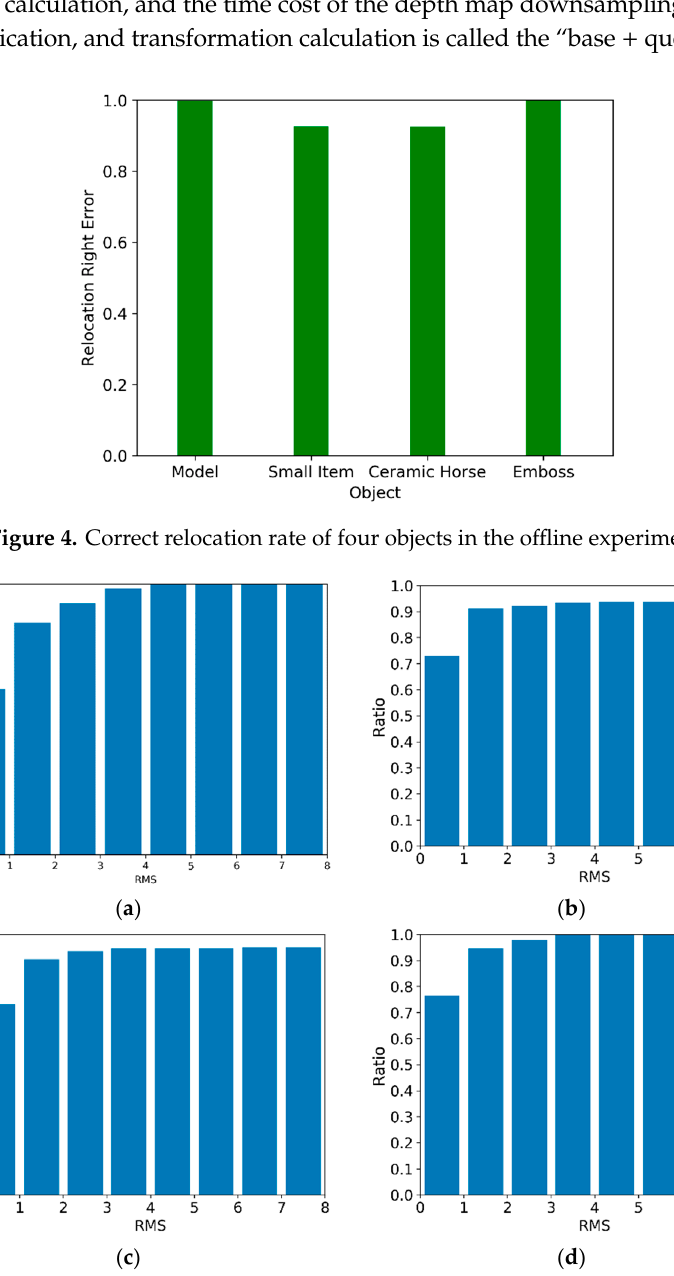
Figure 5. Histogram of cumulative distribution of the relocation RMS errors in the offline experiment. ( a – d ) are the RMS error cumulative distribution histogram of the model, small items, ceramic horse, and emboss objects.